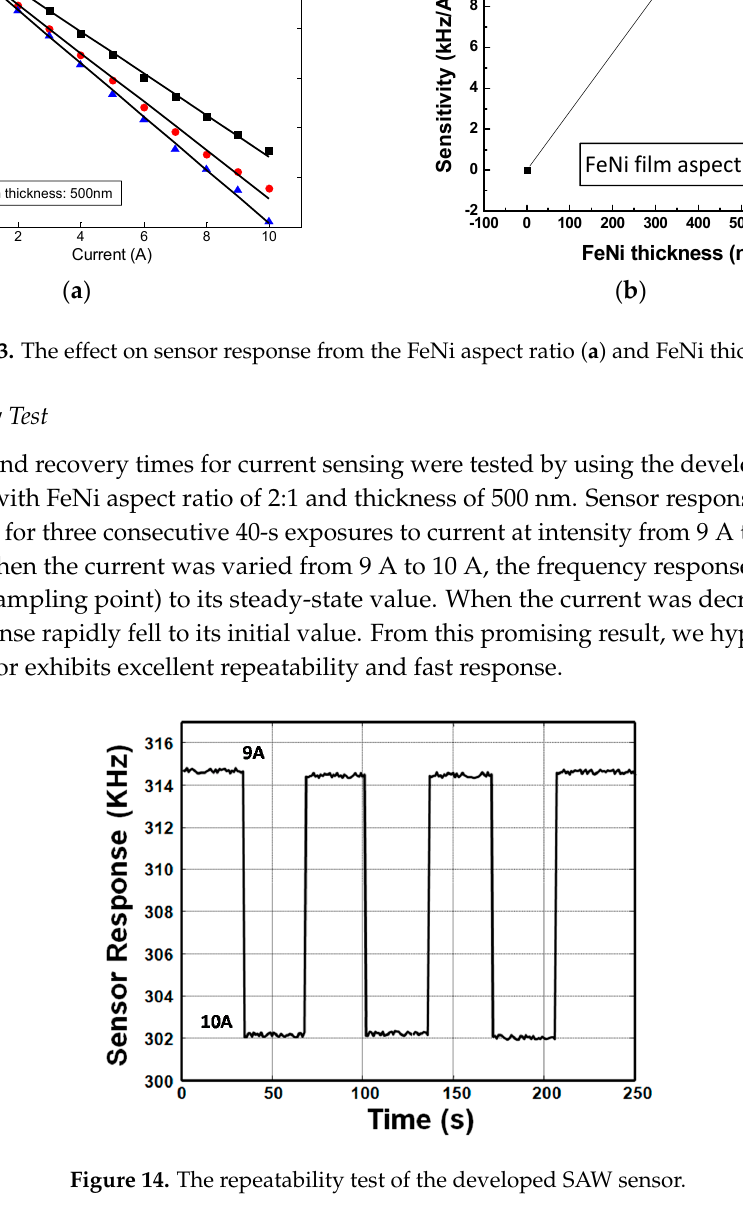
Figure 12. The measured magnetostrictive curves for FeCo and FeNi.